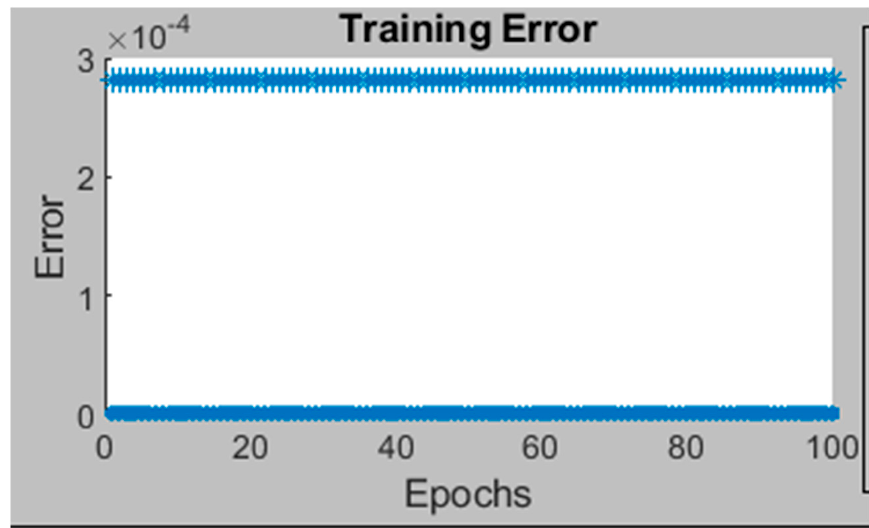
Figure 19. ANFIS structure developed using Subtractive clustering.